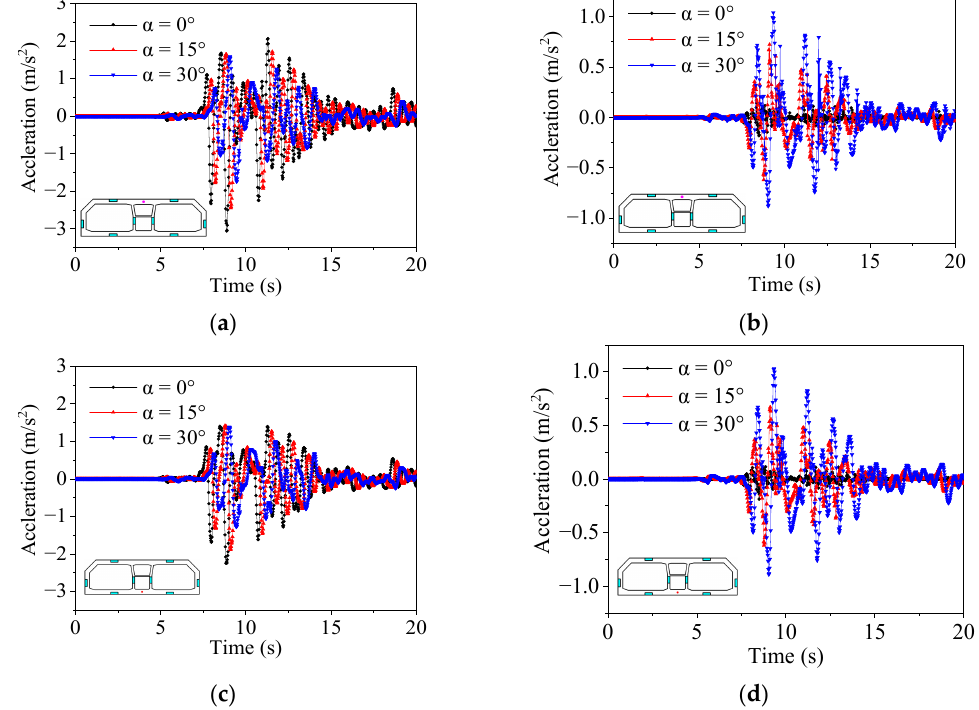
Figure 12. Acceleration time history of monitoring point: ( a ) horizontal acceleration of roof midpoint; ( b ) vertical acceleration of roof midpoint; ( c ) horizontal acceleration of floor midpoint; ( d ) vertical acceleration of floor midpoint.